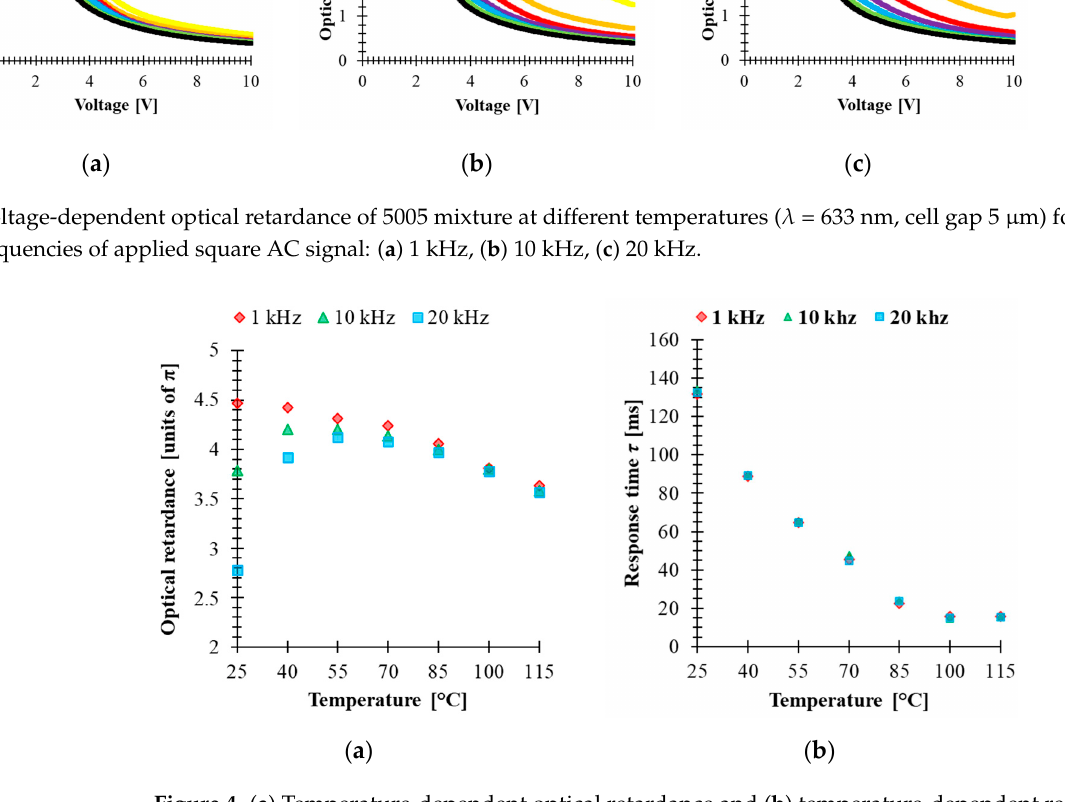
Figure 4. ( a ) Temperature-dependent optical retardance and ( b ) temperature-dependent response time of 5005 mixture ( λ = 633 nm, cell gap 5 μ m) while controlled by 1 kHz, 10 kHz and 20 kHz of 10 V square-wave AC signal.